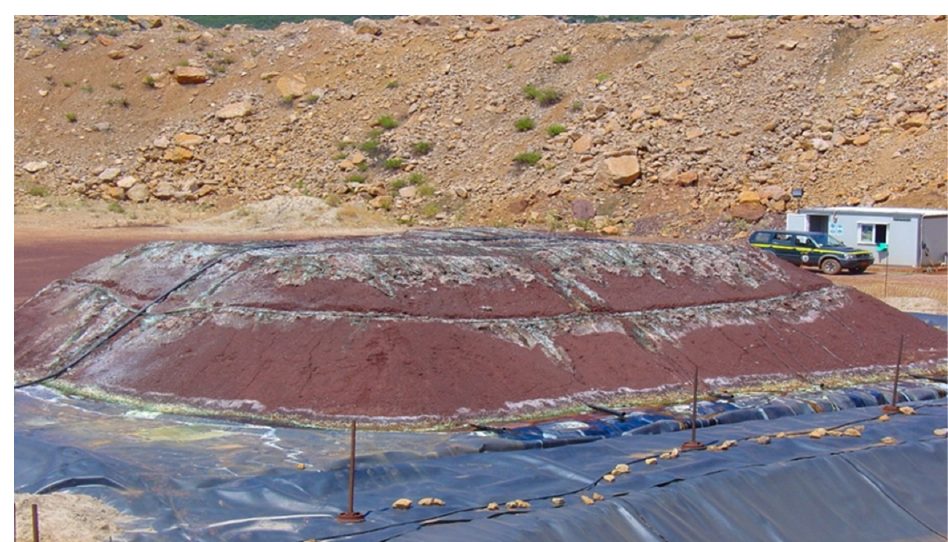
Scheme 2. View of the heap during